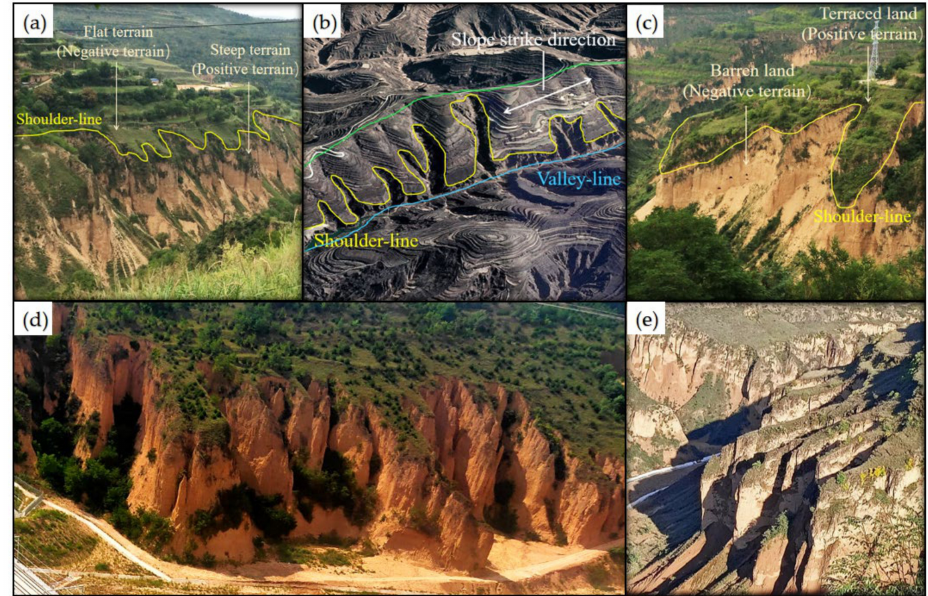
Figure 2. Demarcation basis of the shoulder line: ( a ) geomorphic features of the shoulder line; ( b ) spatial distribution of the shoulder line; ( c ) land use of the shoulder line; ( d ) jagged erosion; ( e ) palm-shaped